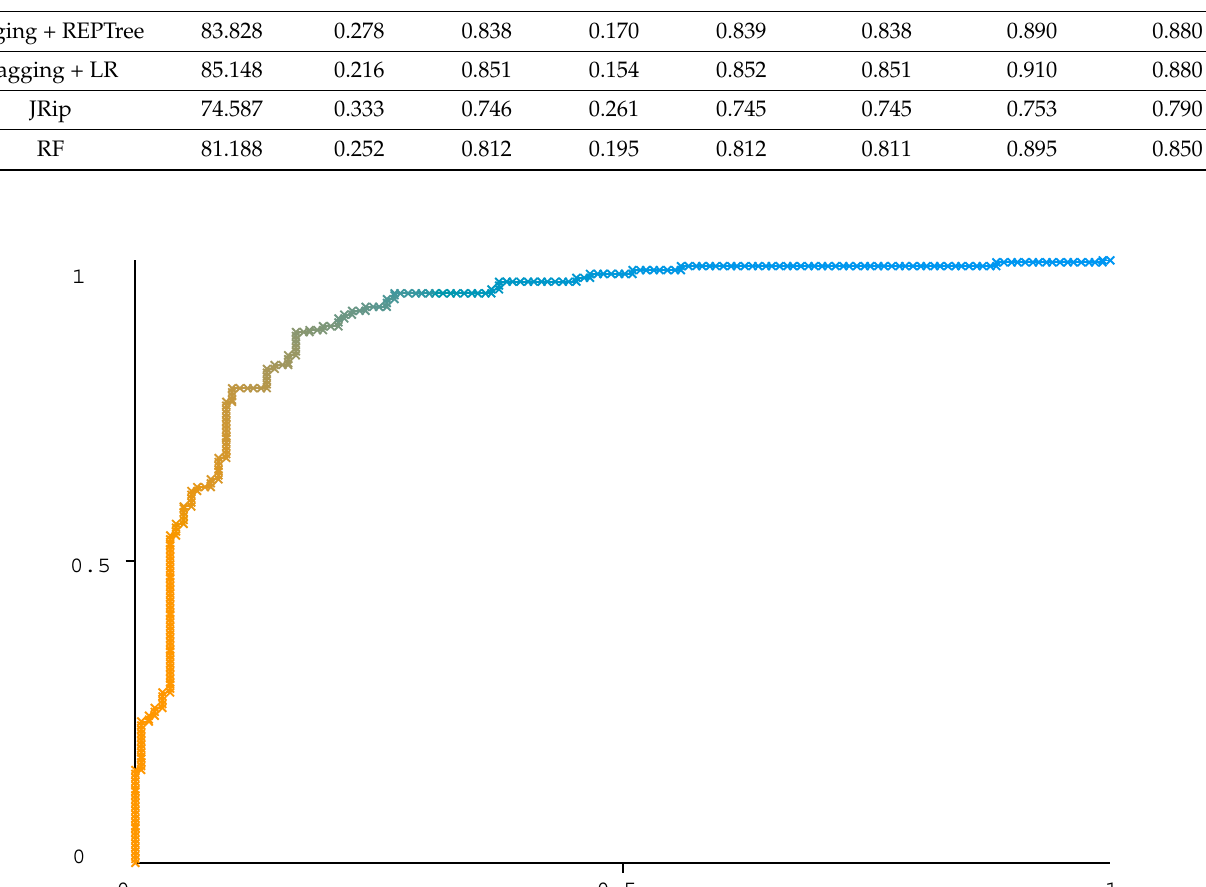
Figure 10. Performance metrics based on the optimal set obtained using the ReliefF attribute evaluation. A comparison of the accuracy values using the full set of attributes of the Cleveland dataset and optimal attribute sets obtained using various attribute selection techniques performed in this work is shown in Table 11. The correlation-based feature selection method was not able to provide an accuracy value greater than that of the full attribute space. However, there was an improvement in accuracy of about 2% and 1% from the IBk and AdaBoostM1 + DS classifiers, respectively. Besides providing the highest accuracy of 86.468% from SMO, the chi-squared attribute evaluation technique improved most of the classifiers’ performances, except for the NB, LR, and AdaBoostM1 + LR classifiers. An